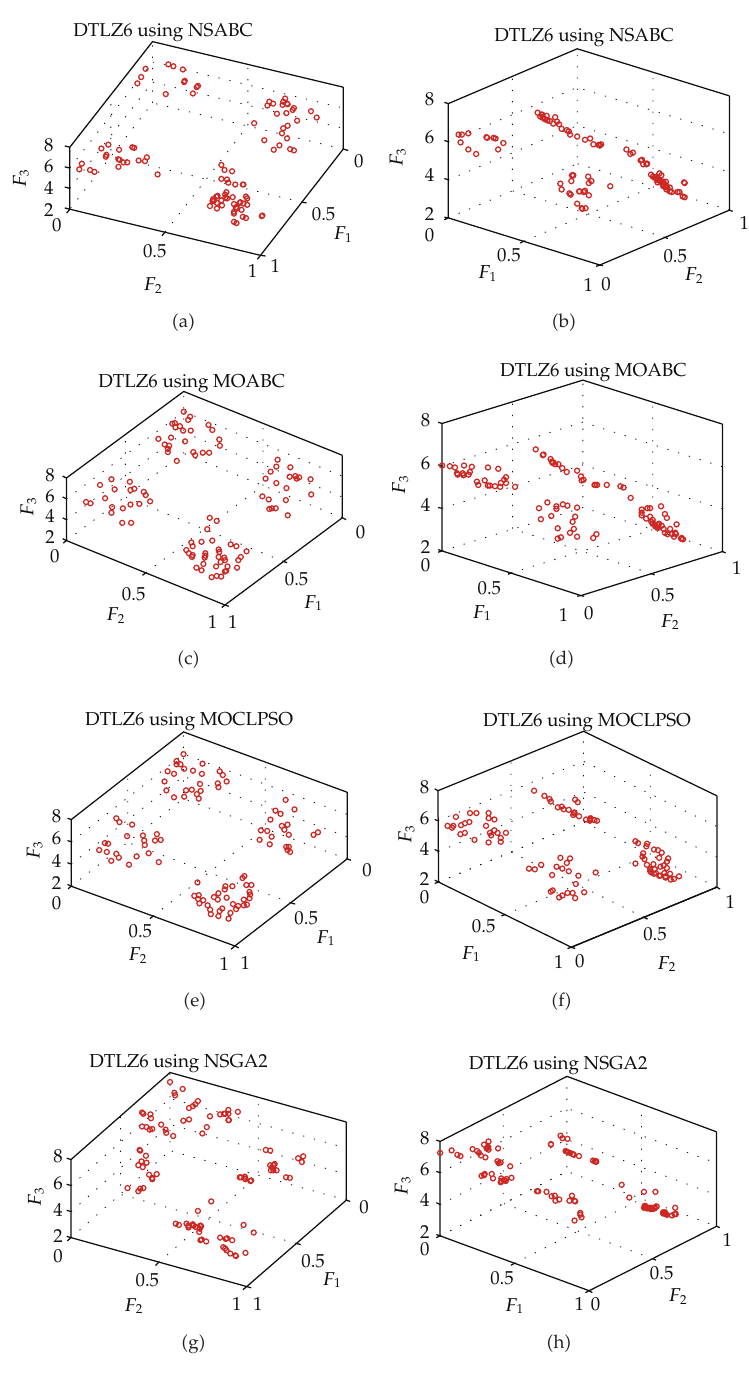
Figure 20: Pareto fronts obtained by NSABC, MOABC, MOCLPSO, and NSGA-II on DTLZ6 after 20000